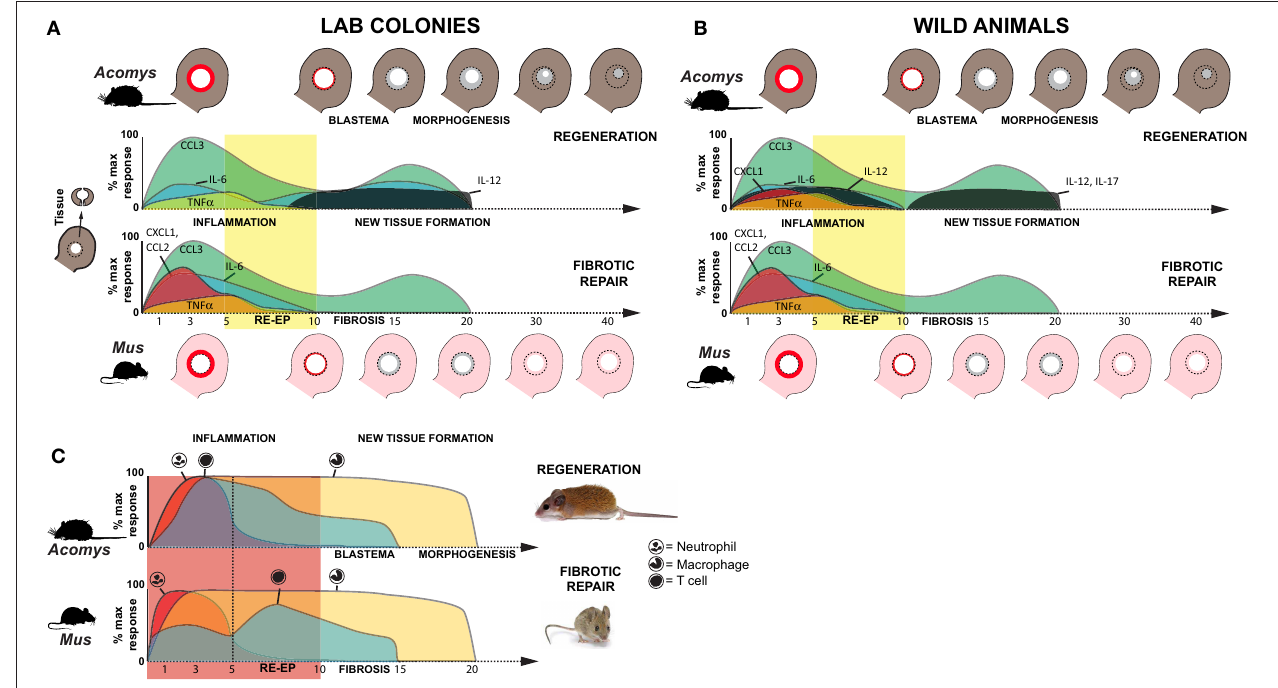
FIGURE 7 | Inflammation is a hallmark of regeneration and fibrotic repair. (A,B) Schematic summarizing relative cytokine concentrations measured in healing tissue relative to baseline (uninjured tissue) for lab (clean, immune naïve) (A) and wild (dirty, immune challenged) (B) animals in this study. Cartoons of the ear pinna show the initial injury (dotted circle depicting 4mm hole punch), local inflammation (red ring in punched area), and new tissue (gray area inside dotted circle) closing the hole ( Acomys ) or producing a scar to leave an open hole ( Mus ). Colored areas on the graphs represent cytokine concentrations as a percentage of the max response from Figure S2 . Although similar cytokines are induced after injury, during acute inflammation in non-regenerating species there is a greater magnitude increase in several proinflammatory cytokines (IL-6, CXCL1). While the chemokine CCL2 (MCP-1) was strongly induced in non-regenerating species, it remained near baseline in wild Acomys . Regardless of the magnitude change, resolution of cytokine concentrations at or below baseline occurred around D10 and supported this timeframe as the transition to new tissue formation; a finding supported by cellular and genetic data ( 41–43). In further support of this transition, we observed a marked increase of IL-12 during new tissue formation in regenerating species and of IL-17 in wild Acomys . (C) Schematic summarizing data for neutrophil, macrophage and T cell infiltration based on this study and previously published data ( 16). Relative leukocyte numbers do not account for differences in potential subpopulations and macrophage numbers include resident and circulating